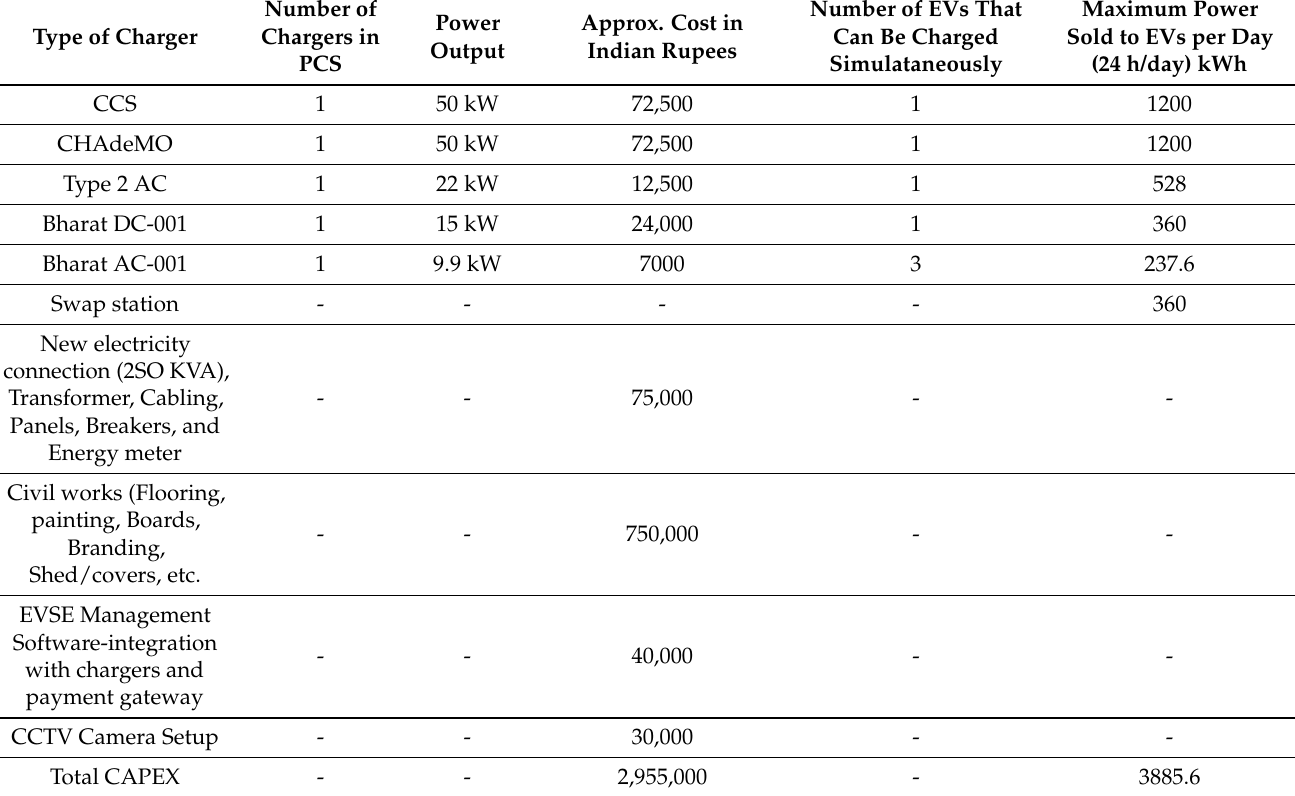
Table 3. CAPEX: Cost estimation of the proposed multi-level charging infrastructure.